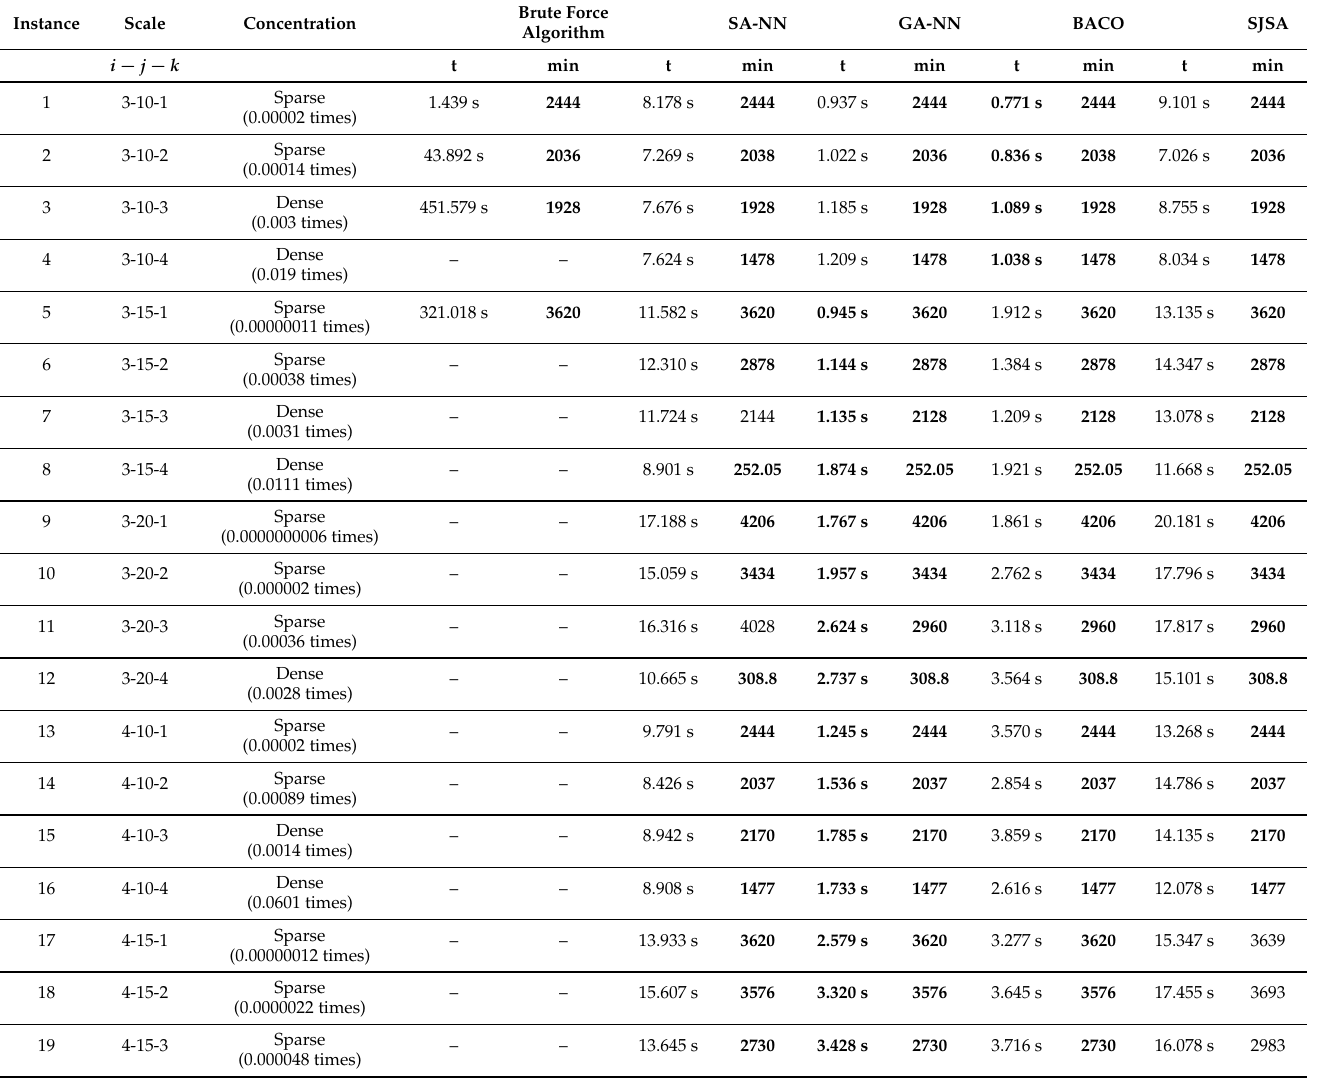
Table 4. Experimental